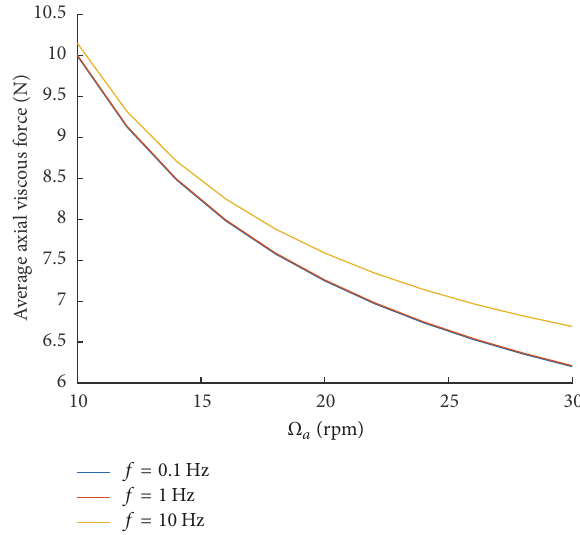
Figure10:Influenceoffrequencyoftorsionaloscillationontheaxial viscous force.